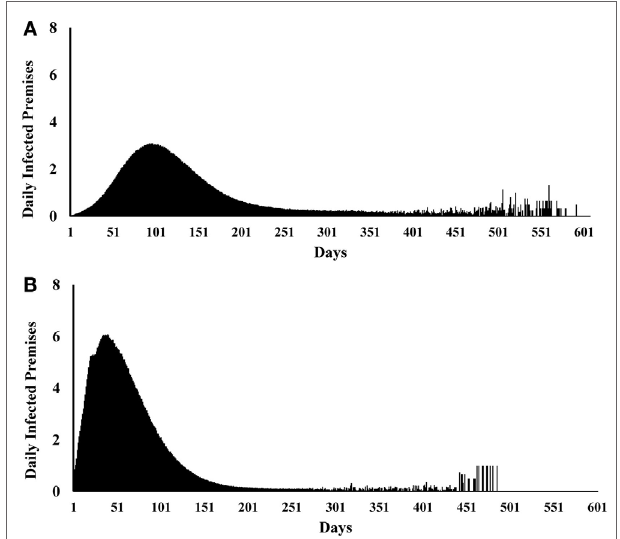
FigUre 3 | epidemic curves for (a) 19 most likely single-site classical swine fever outbreak scenarios ( N = 9,500 iterations). (B) 15 most likely multiple-site outbreak scenarios ( N = 7,500 iterations).